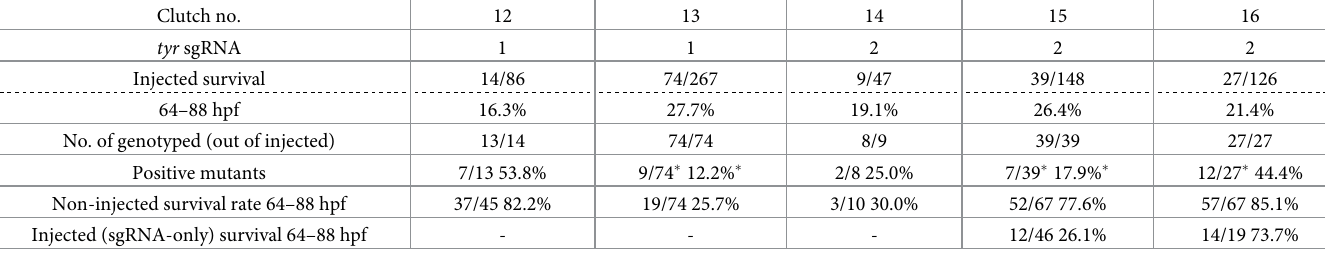
Table 2. Clutch survival and mutation rates for tyr targeted injection rounds. Survival rates of embryos injected with sgRNA/Cas9 or sgRNA-only targeting tyr , and non-injected embryos at time of collection (64–88 hpf), number of genotyped embryos, and mutation rate per clutch and target sequence. Clutch